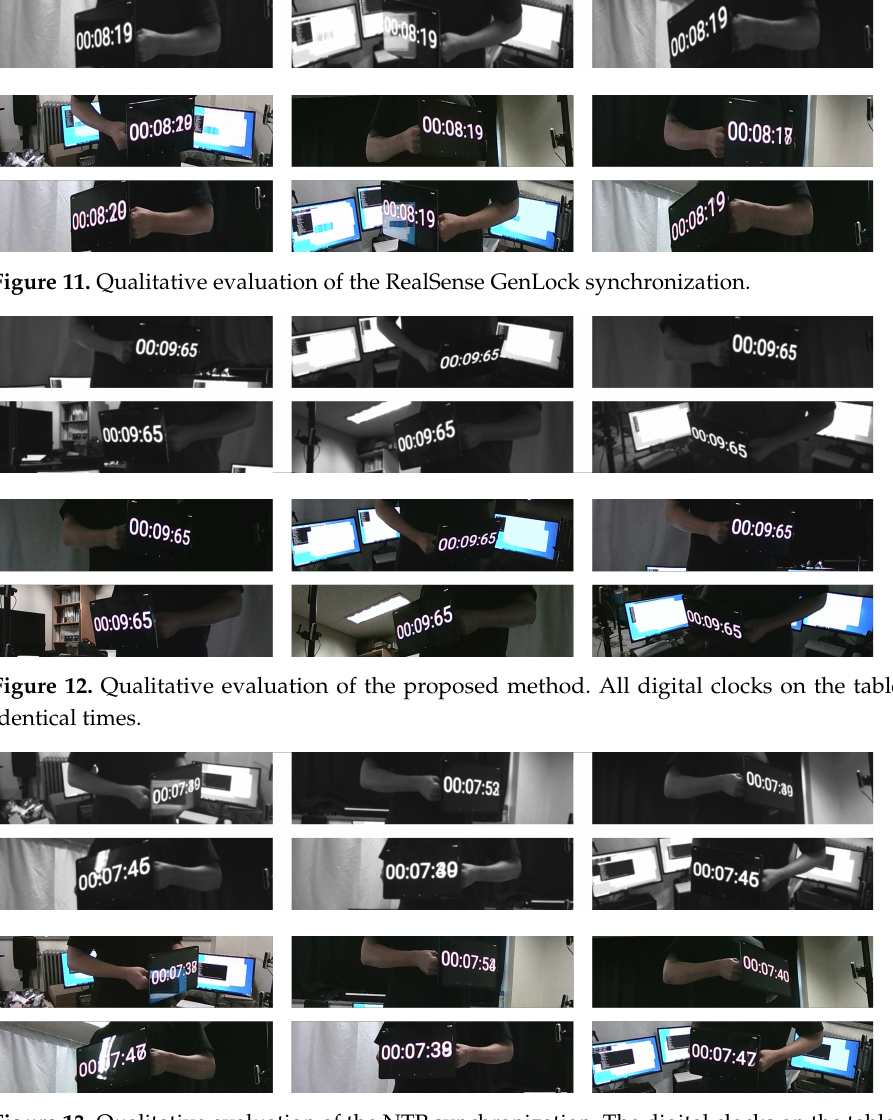
Figure 13. Qualitative evaluation of the NTP synchronization. The digital clocks on the tablet do not show identical